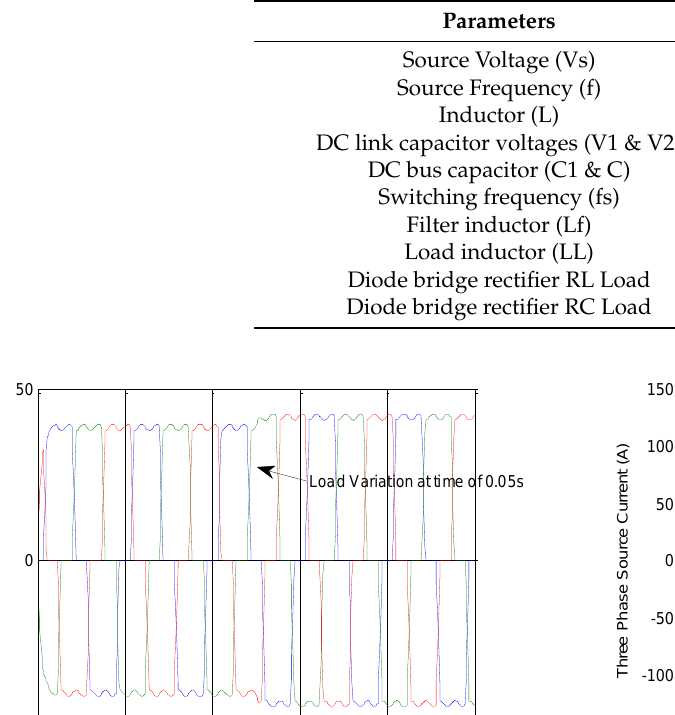
Figure 7 indicates the simulated responses of the source current and THD of the power system without SAPF at different load conditions. Table 2. Specifications of three phase SSI Based SAPF used for the simulation. Table 2. Specifications of three phase SSI Based SAPF used for the simulation.